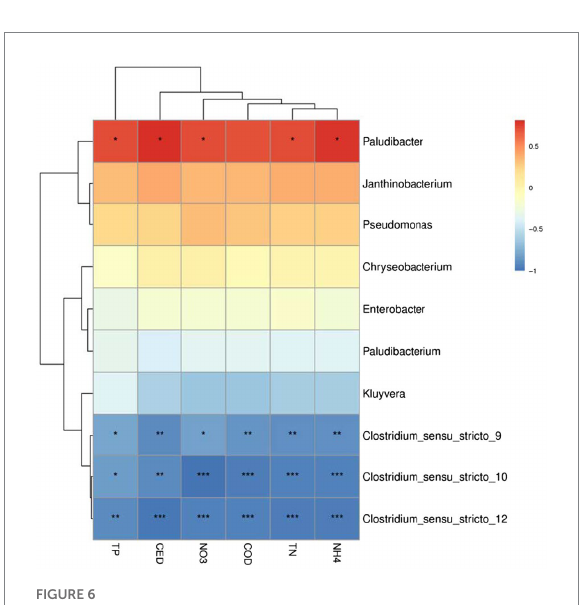
FIGURE 6 Heatmap analysis of correlation between microbial dominant genera and pollutants removal